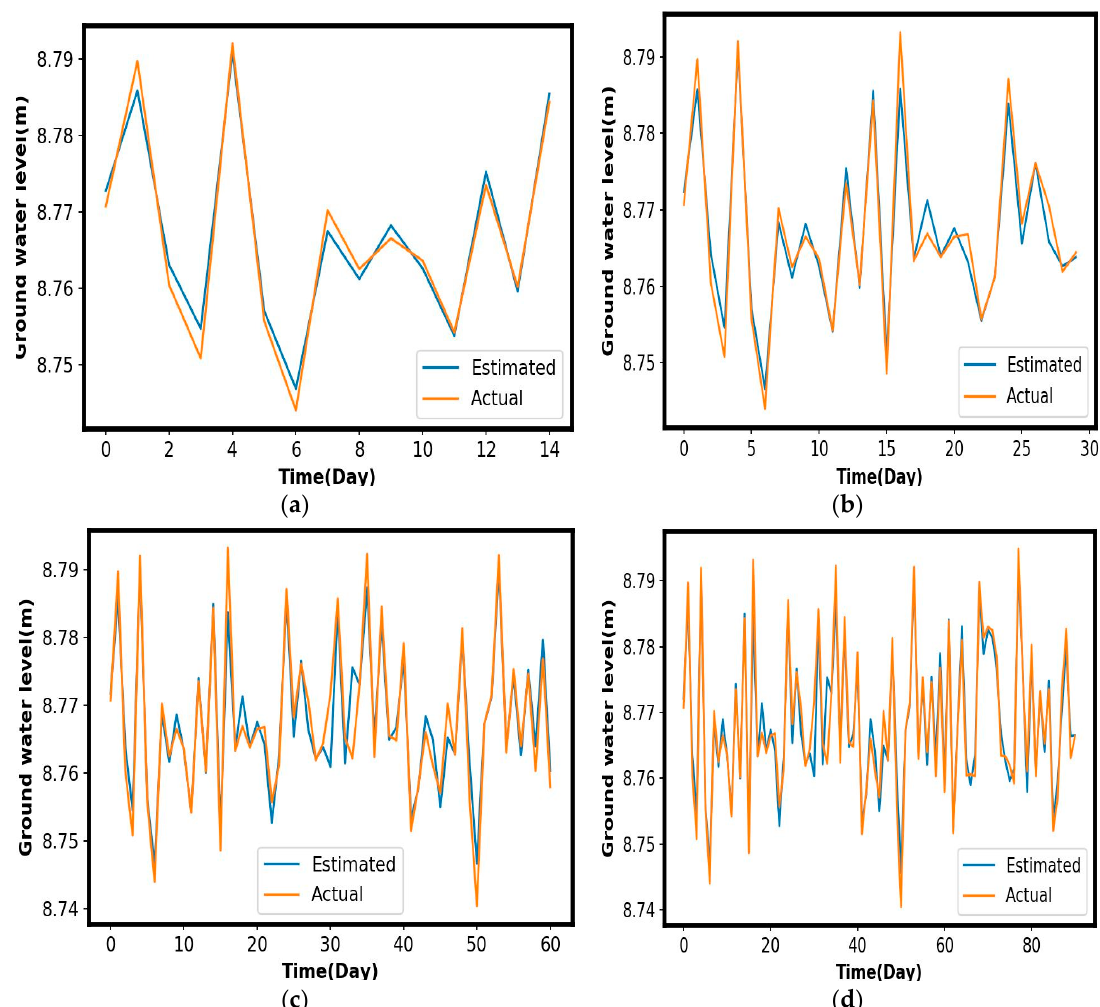
Figure 9. Assessment of the actual and the estimated groundwater levels of the optimal KNN-RF model for 15, 30, 60, and 90 days (corresponding to a–d , respectively) lead time in the testing phase.